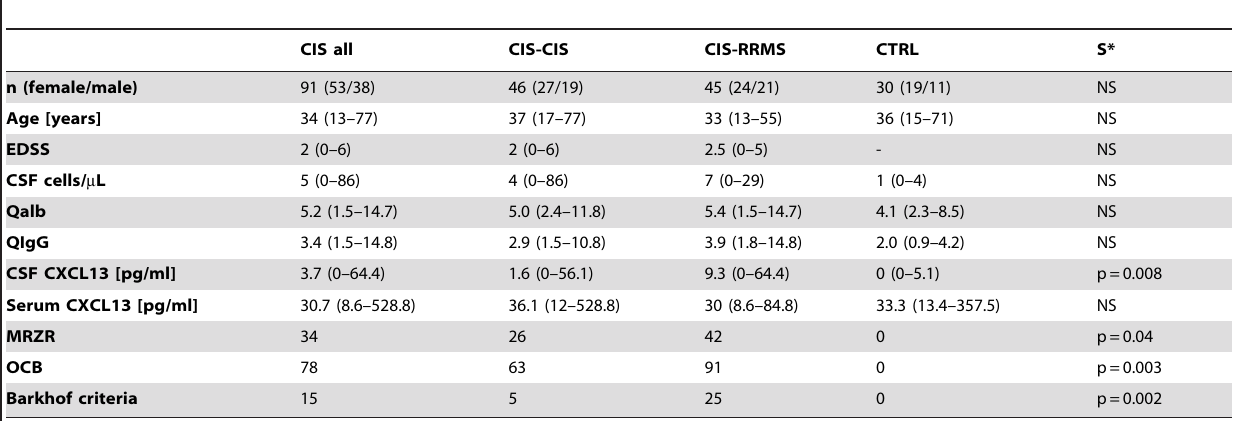
Table 1. Demographic data, CSF, serum and MRI findings in patients with clinically isolated syndrome (CIS) and controls.